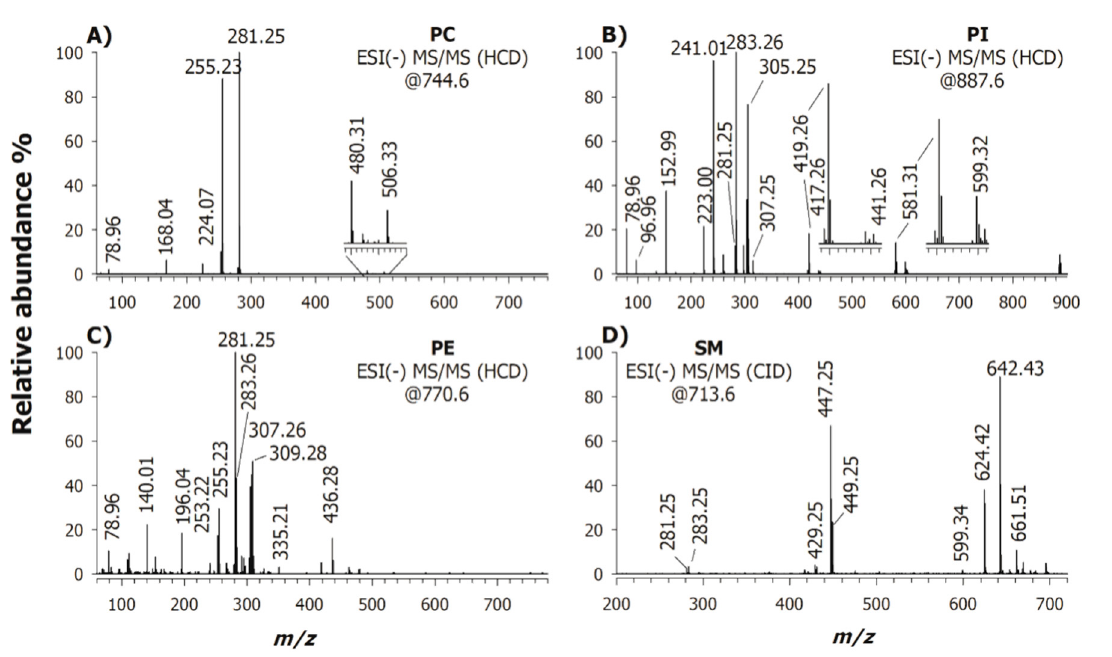
Figure 4. ESI(-)-MS/MS spectra of four glycerophospholipid putative biomarkers of PD (normalized Figure 4. ESI(-)-MS / MS spectra of four glycerophospholipid putative biomarkers of PD (normalized collisional energy, 35%). ( A ) FTMS/MS spectrum of a PC at m/z 744.6 isolated as demethylated ion, collisional energy, 35%). ( A ) FTMS / MS spectrum of a PC at m / z 744.6 isolated as demethylated ion, [M − , ( B ) FTMS / MS spectrum of a PI at m / z 887.6 isolated as deprotonated molecule [M − H] − , ( C ) − CH 3 ] FTMS / MS spectrum of a PE at m / z 770.6 as [M − H] − , and ( D ) linear ion trap (LIT) MS / MS spectrum of a SM at m / z 713.6 as [M − CH 3 ] −